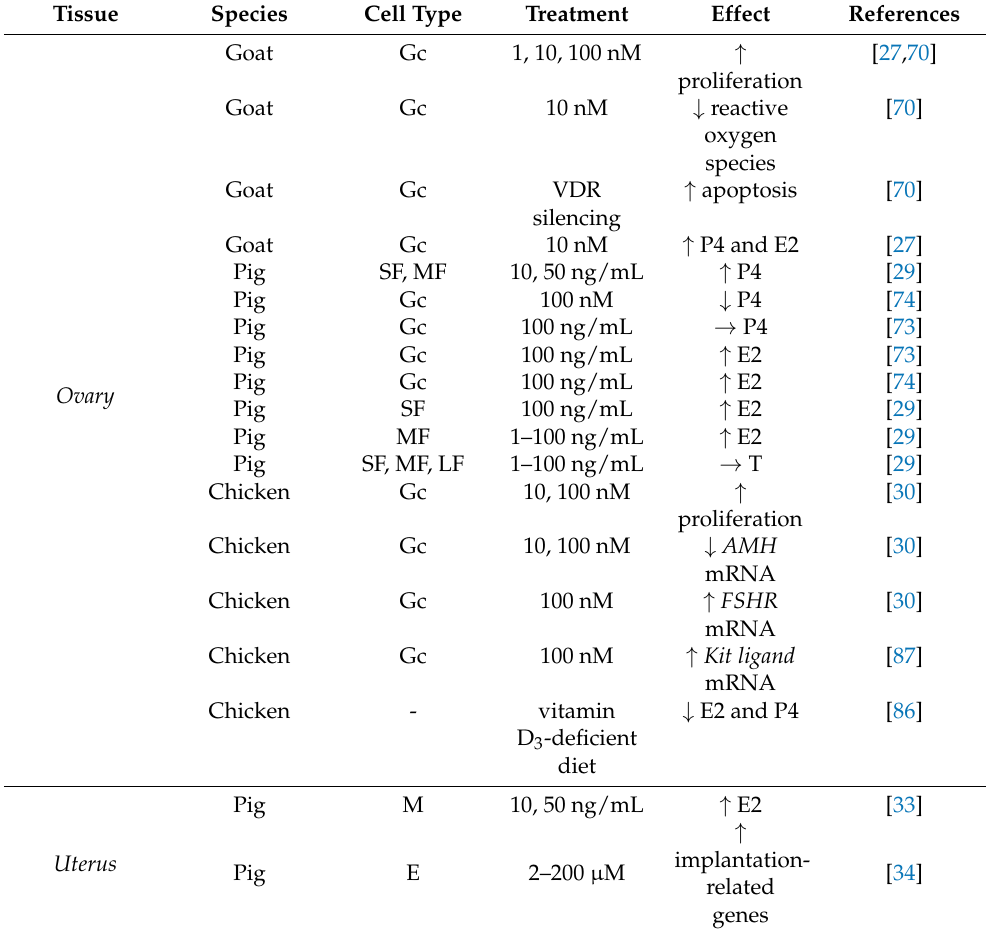
Table 2. Effects of vitamin D 3 on the female reproductive system of farm animals and